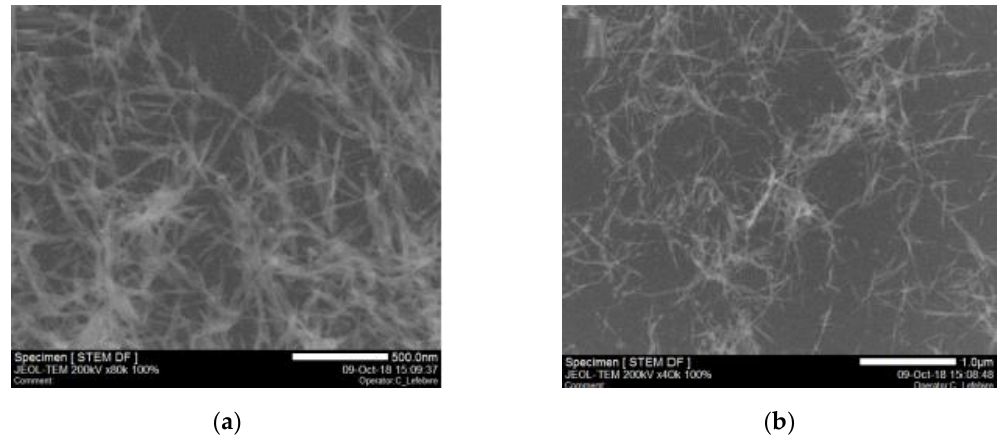
Figure 3. STEM micrographs of Cellulose Nanocrystals (CNC) particle; ( a ) 500 nm resolution and ( b ) 1 μm resolution.